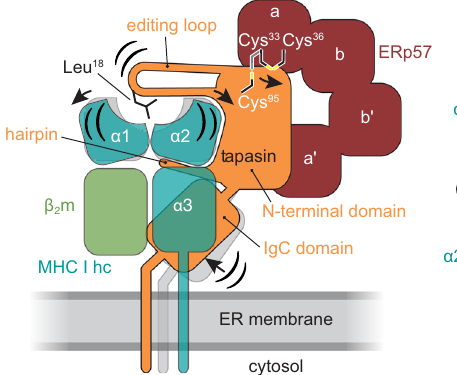
Fig. 5 | Model for chaperone function of tapasin towards peptide-receptive MHC I. Schematic of molecular motions leading to stabilized peptide-receptive clients(MHCIhc,teal; β 2 m,green)uponassociationwithtapasin(orange;left,side view; right, top view). Conformational changes are indicated by black arrows. The